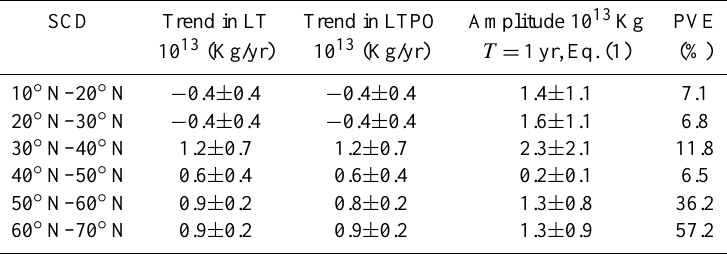
Table 6. SCD at different latitudes; the uncertainty is at the 95% confidence level.